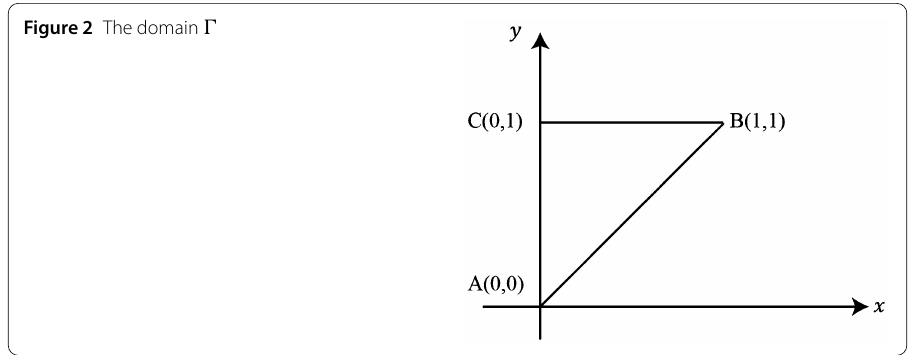
Figure 2 The domain